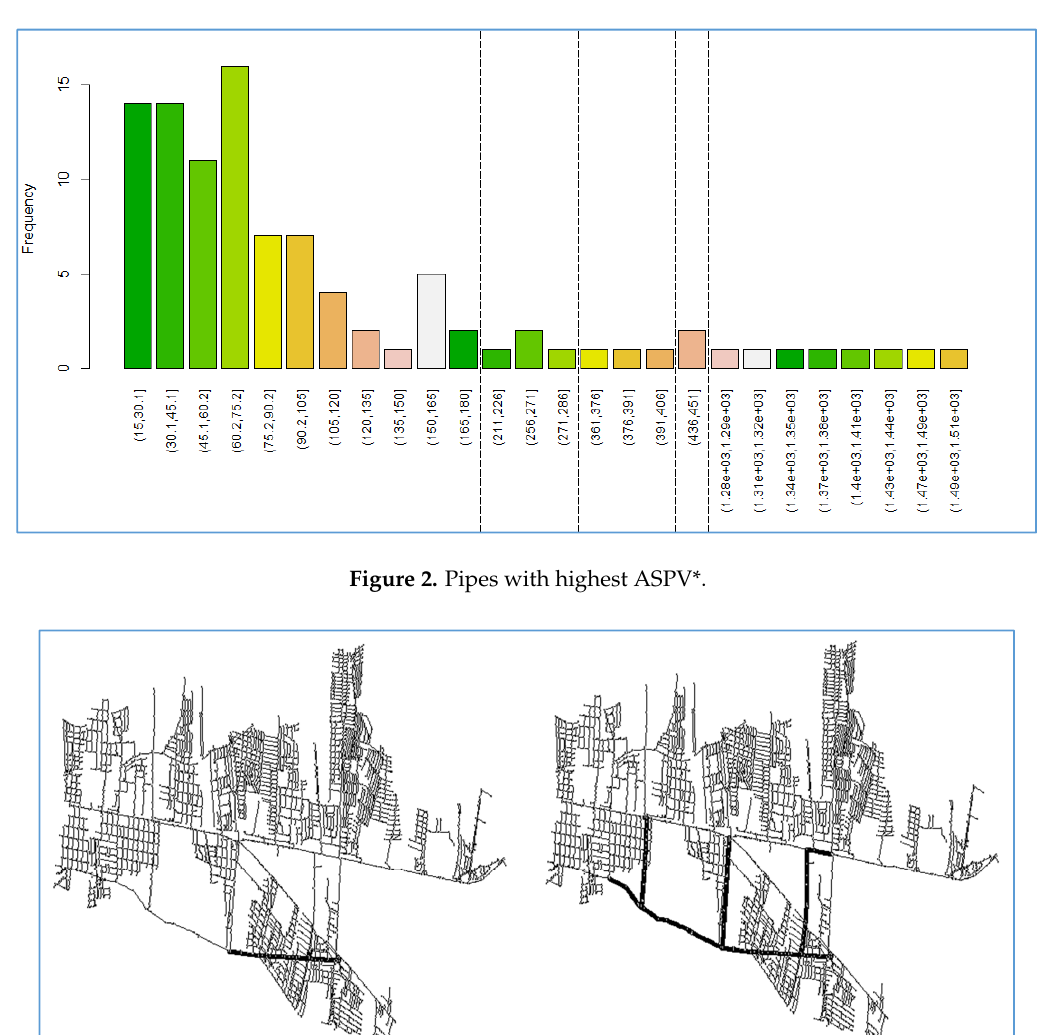
Figure 1. Pareto diagram of the frequency table of ASPV**. 2016 , 8 , 179